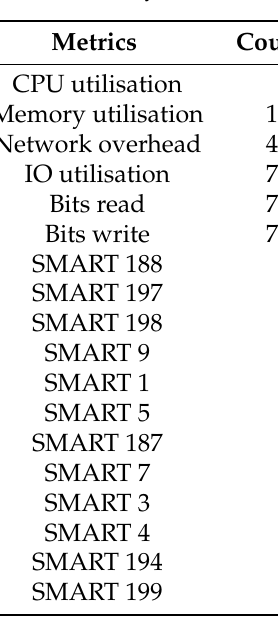
Table 2. Summary of the data distribution (mean and standard